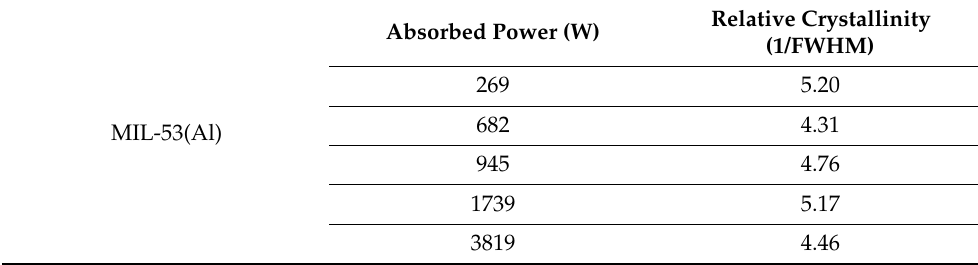
Table 1. The elative crystallinity of